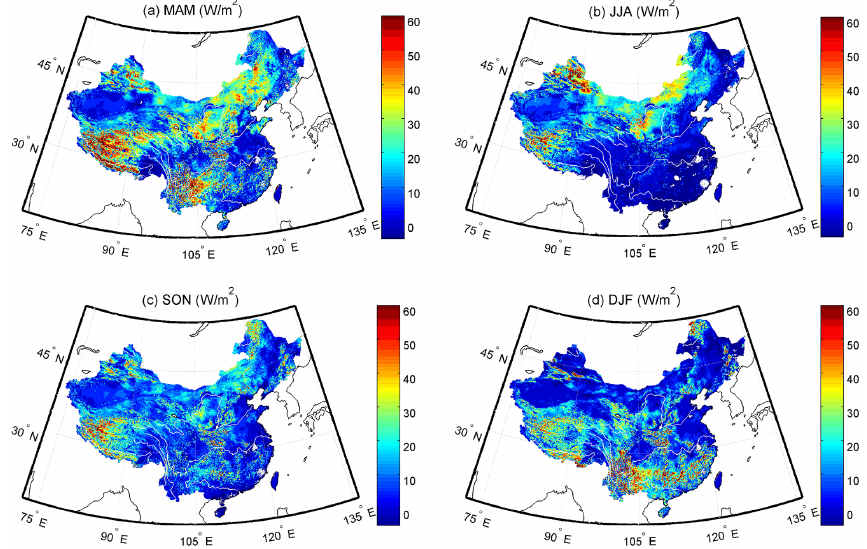
Figure 9. Maps of seasonal average sensible heat flux for (a) March–May (MAM), (b) June–August (JJA), (c) September–November (SON), and (d) December–February (DJF) from 2001 to 2010. Black lines show several major rivers in